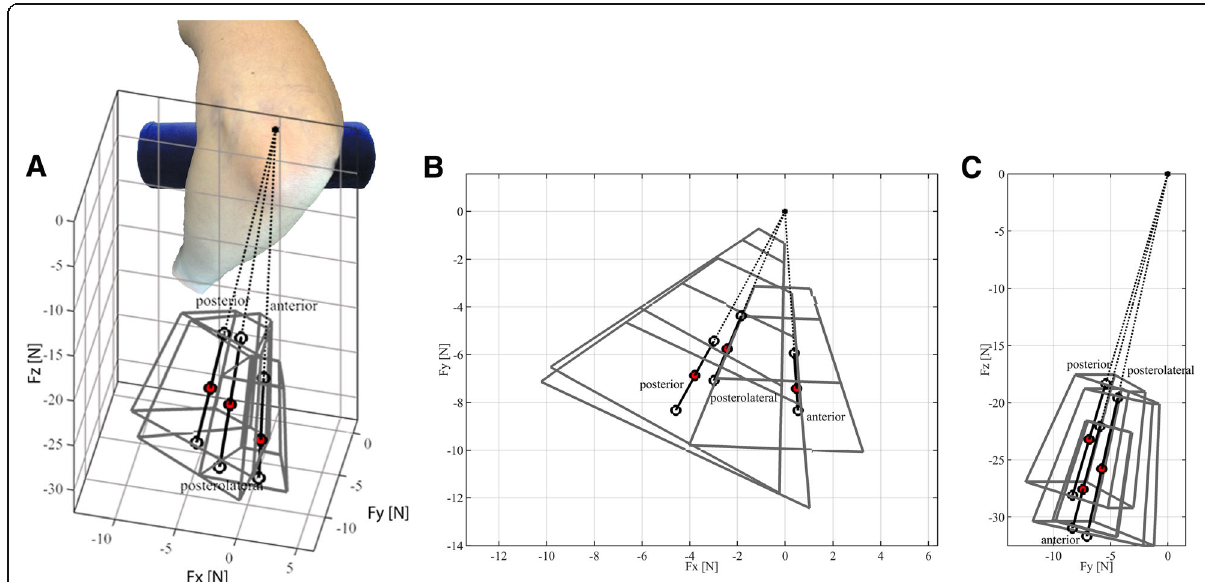
Fig. 6 Safe force zone (magnitude and direction) for all compartments. The red dots indicate the median value of F abs , α and β for each compartment. The thick black lines with white dots at their respective ends represent the 10th and 90th percentile value of F abs in the median force direction. The grey boxes surrounding the thick black lines indicate the combined boundaries of the 10th -90th percentiles for F abs , α and β . The origin is taken at the same position for each compartment. a 3D graphical representation. For reference an elbow in the lateral decubitus position is added. So the forces are directed towards the surgeon, b Top view, c Sagittal